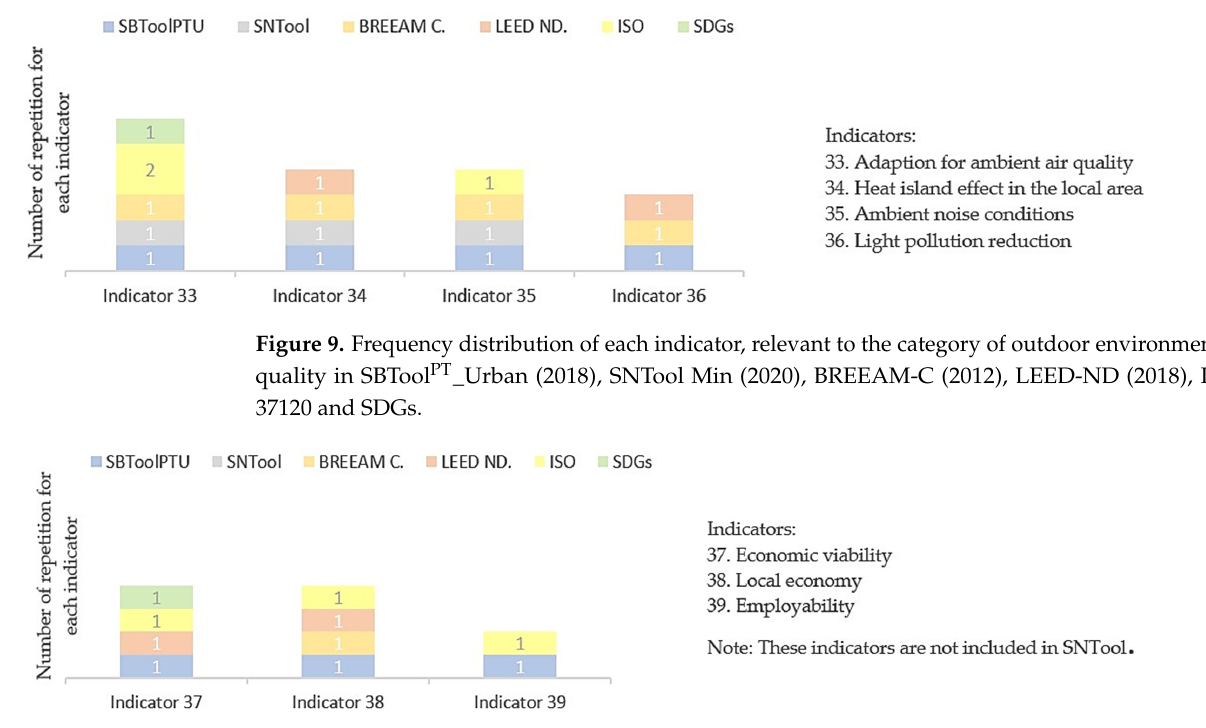
Figure 10. Frequency distribution of each indicator, relevant to the category of employment and economic development in SBTool PT _Urban (2018), SNTool Min (2020), BREEAM-C (2012), LEED-ND (2018), ISO 37120, and SDGs.